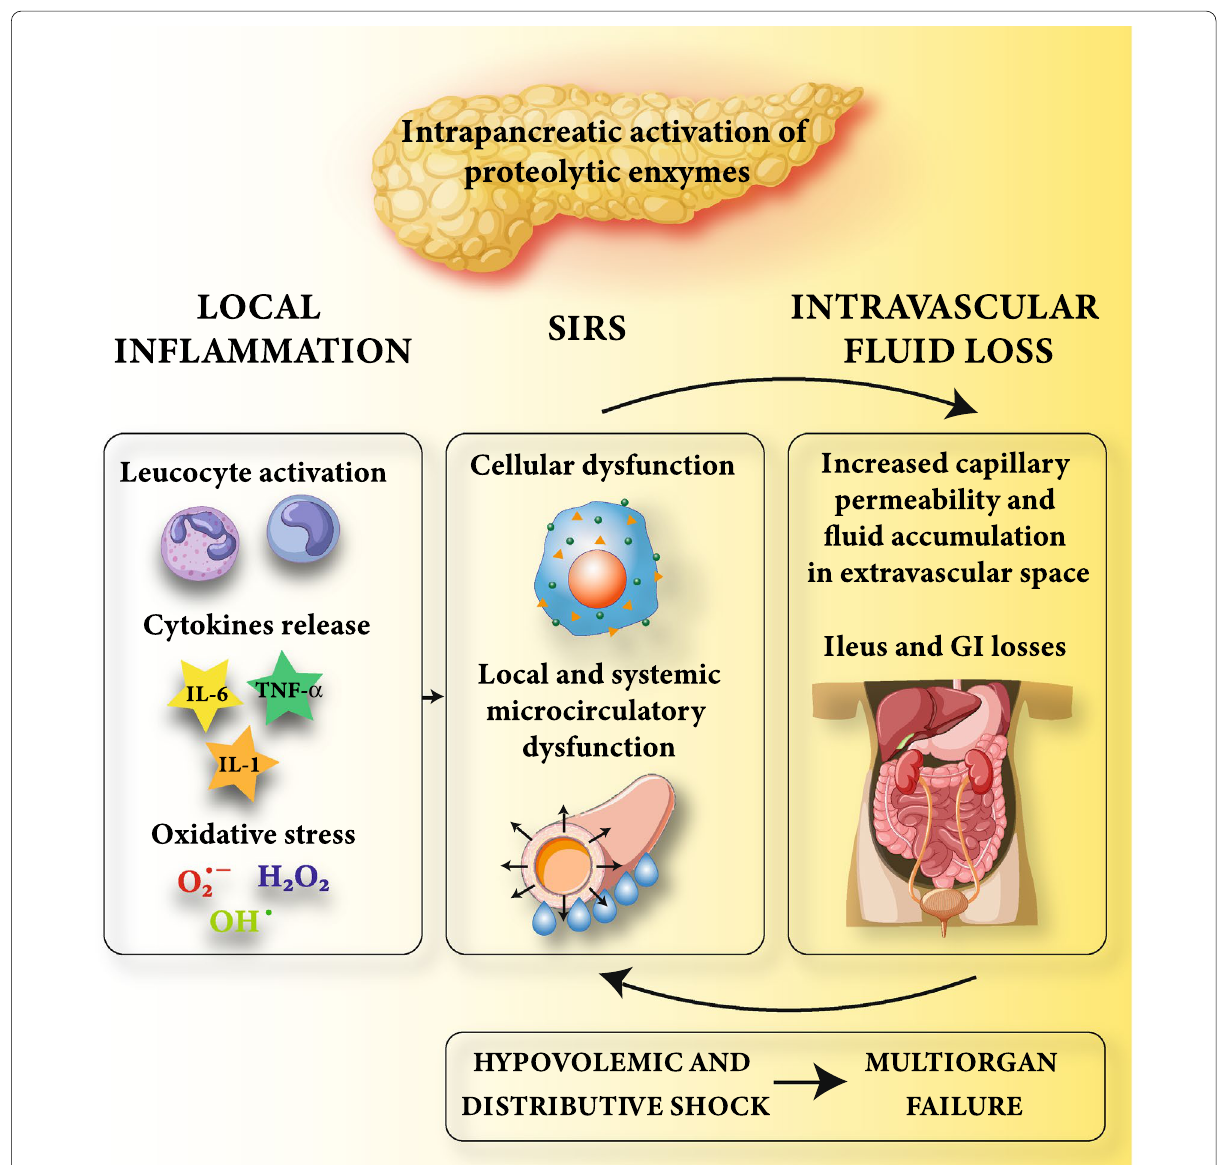
Fig. 1 Pathophysiology of fluid loss/hypovolemia in patients with severe acute pancreatitis. The intrapancreatic activation of proteolytic enzymes causes local tissue inflammation with leukocyte activation, cytokines, and reactive oxygen species release. At a systemic level, the massive release of pro-inflammatory cytokines from the injured pancreas leads to SIRS, causing an intravascular fluid loss through vasodilatation, cellular dysfunction, and increased capillary permeability. Ileus, vomit, decreased fluid intake, and increased insensible losses further contribute to intravascular fluid depletion. If not interrupted, this vicious cycle leads to a severe hypovolemic and distributive shock and ultimately to MOF. IL-1 Interleukin-1; TNF-α Tumor necrosis factor; IL-6 Interleukin-6; SIRS Systemic inflammatory response syndrome; GI Gastrointestinal; MOF Multiorgan